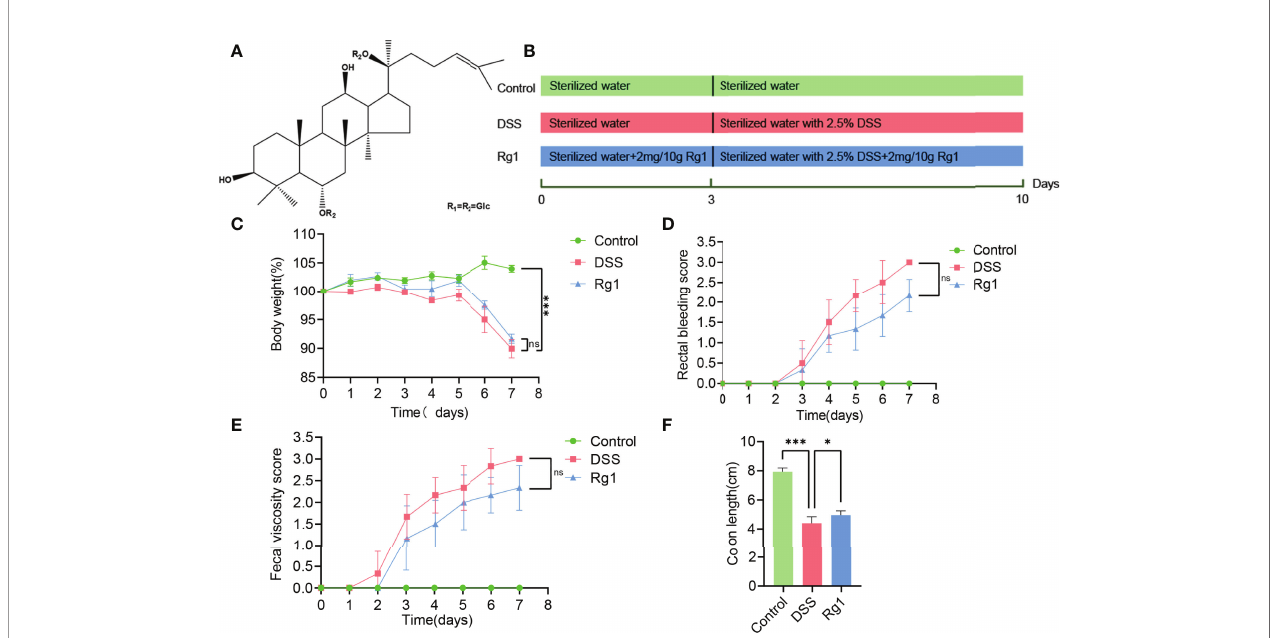
FIGURE 1 | The effect of Rg1 on the DSS-induced UC mice. (A) Chemical structure of ginsenoside Rg1. (B) Inducement of UC mice model and the treatment of Rg1. (C) Daily changes in body weight of each group during UC mice model induction. (D) Changes in fecal bleeding of each group during UC mice model induction. (E) Changes in fecal viscosity of each group during UC mice model induction. (F) Colon length was measured for each group on the 7 th day. Signi fi cance levels are indicated as *P < 0.05, ***P < 0.001 and ns stands for not statistically signi fi